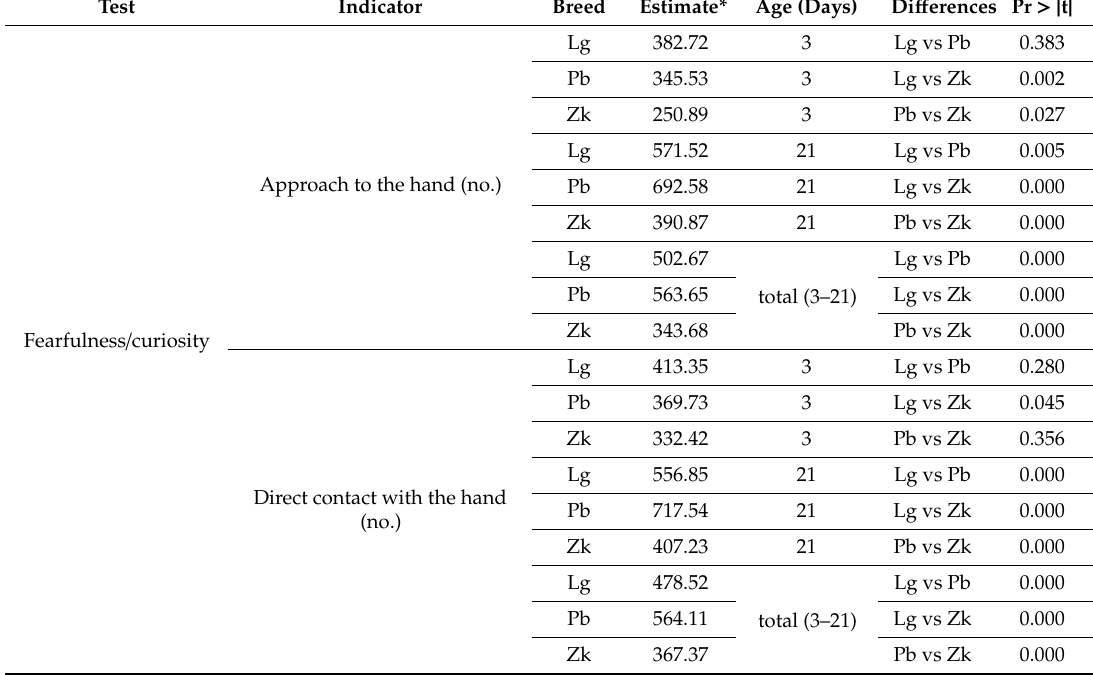
Table 6. Mean level of analysed indicators* and significance of di ff erences between the means in the Fearfulness / curiosity test in relation to the breed and age of chicks.